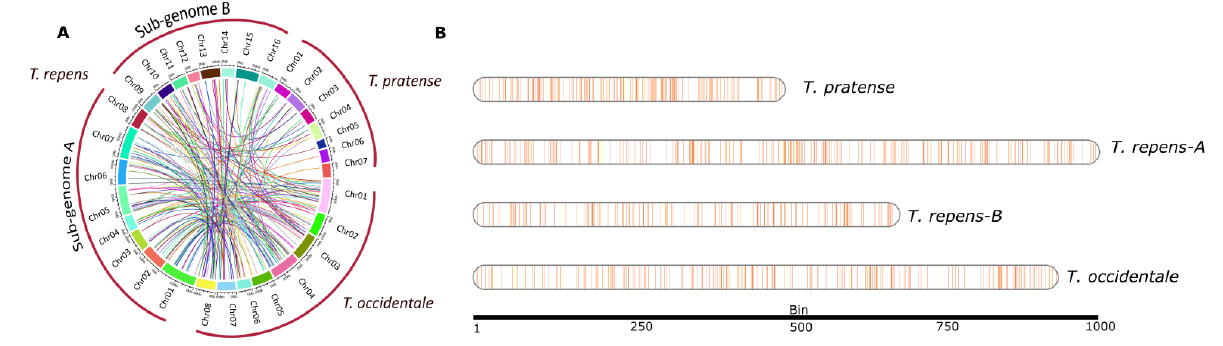
Figure 2. Syntenic and gene density plots of Trifolium species. ( A ) Synteny analysis of NLR genes between T. repens (A and B subgenomes), T. occidentale (progenitor) and T. pratense. ( B ) The NLR genes located on chromosomes are denoted in vertical blue and orange lines, inferring the gene density map between genomes assemblies of three Trifolium species.